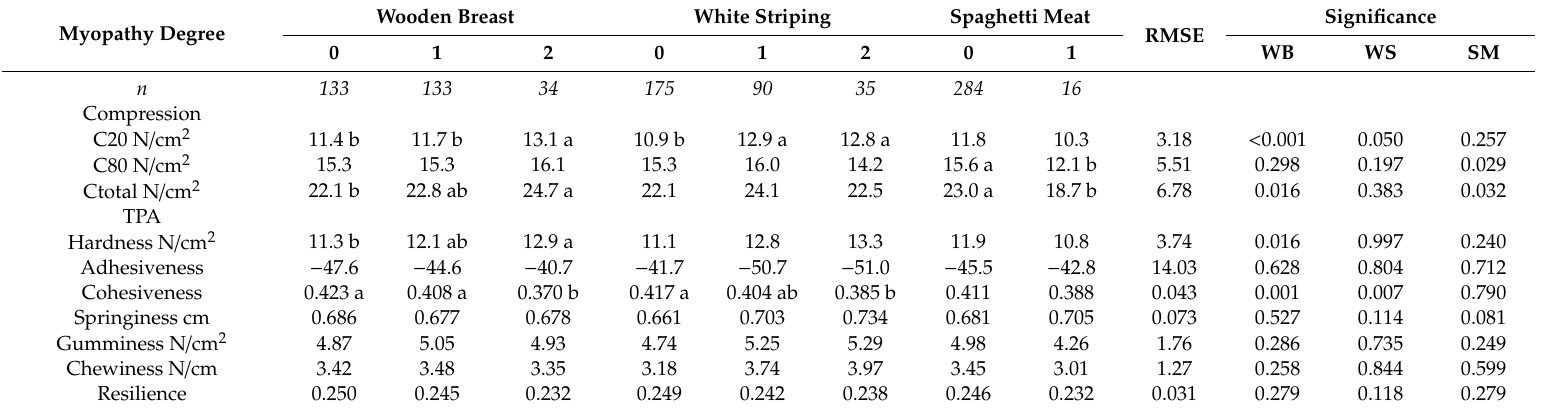
Table 4. Texture of broiler raw breast with di ff erent degree of myopathies by di ff erent texture devices.